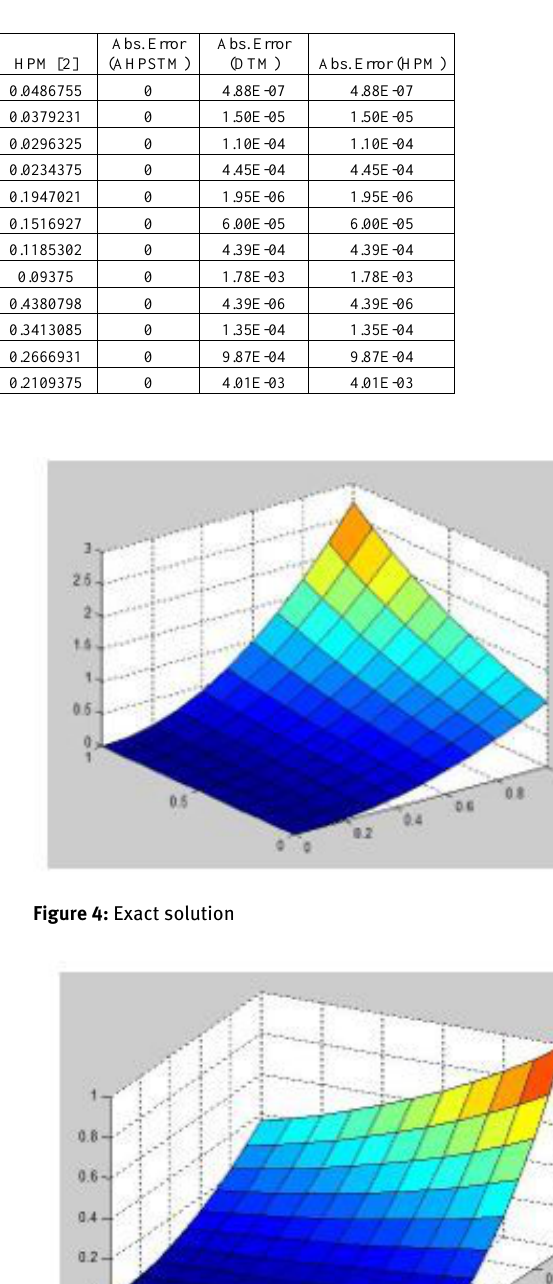
Table 5: Approximate solution of Eq.(19) up to 4 th order approximation